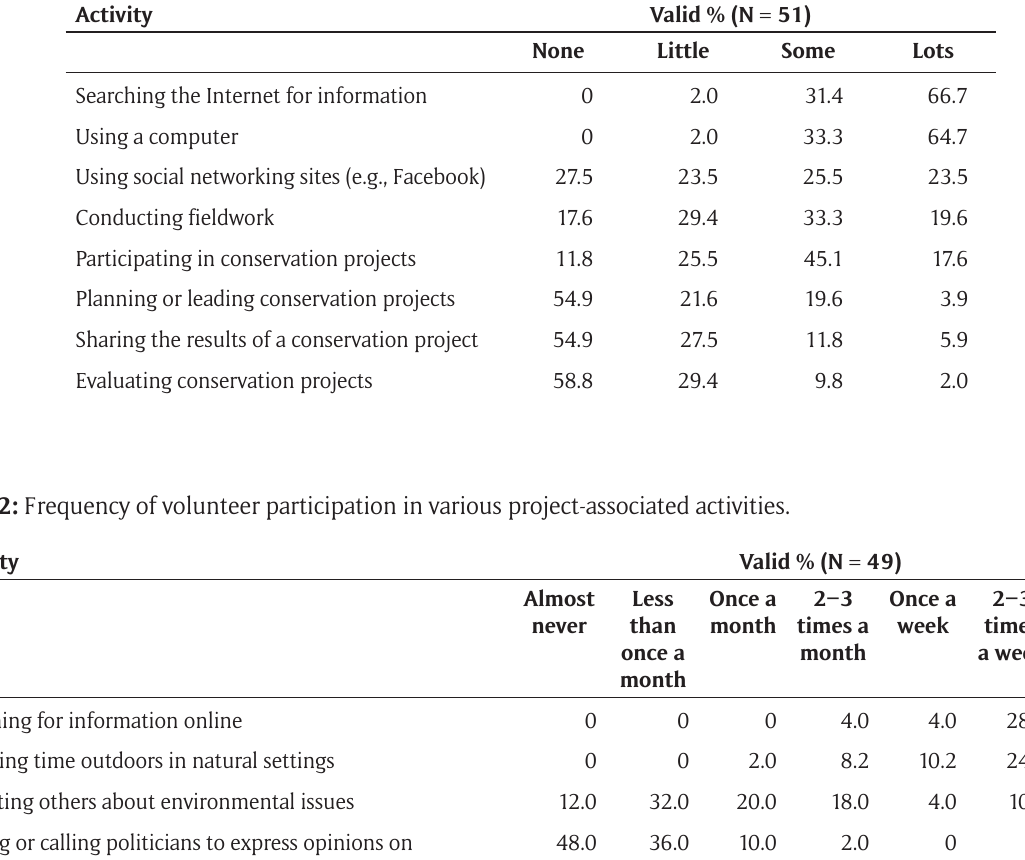
Table 1: Volunteer’s prior experience with activities associated with the project.